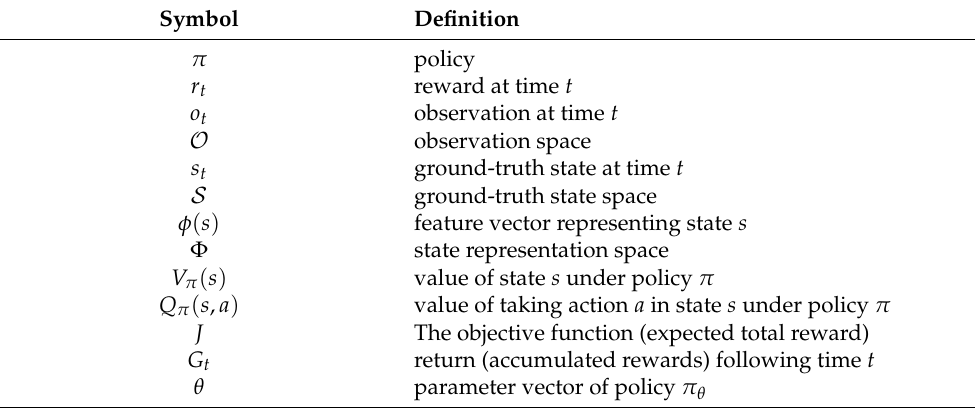
Figure 2. The unsupervised SRL scheme for DRL. The SRL network learns a mapping from original input observations to the embedded features. Table 1. Summary of the notations in this